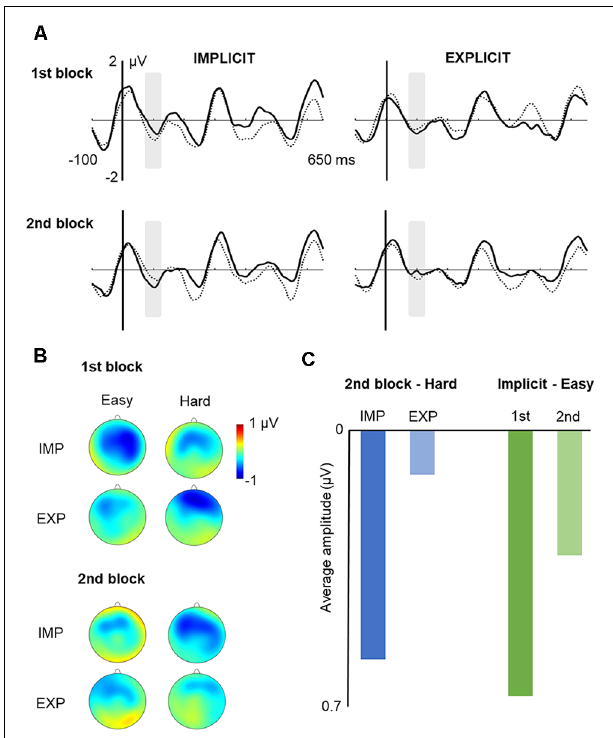
FIGURE 3 | Learning effects on N100 Peak. Note: (A) grand average ERPs at the fronto-central ROI (solid line: hard; dotted line: easy). Gray shaded boxes over the event-related potentials (ERPs) indicate the analyzed time window (80–120 ms). (B) Voltage maps of each condition: fronto-central distribution of the N100 peak. (C) Graphical depiction of the averaged amplitudes for the pairwise comparisons of the triple interaction between SL task, type of “word,” and exposure